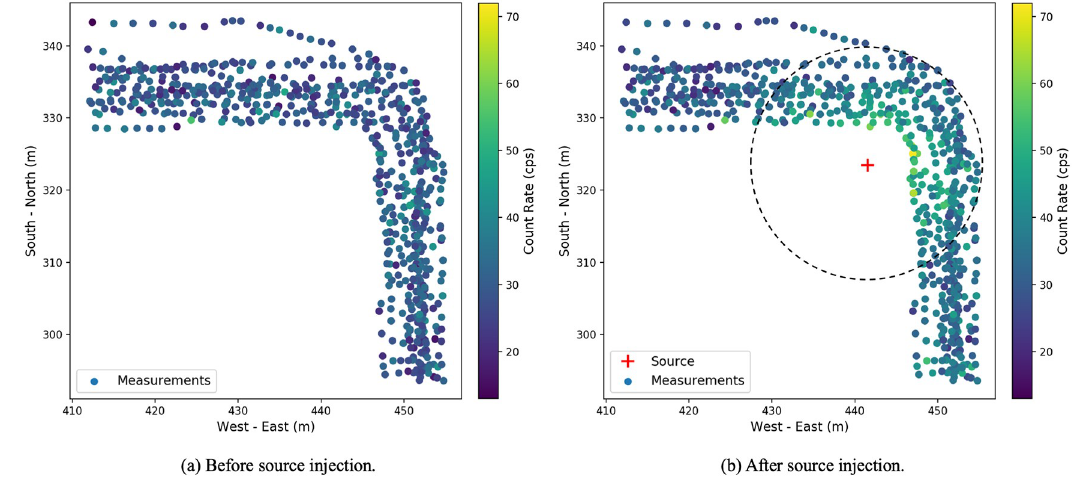
Fig 2. Illustration of synthetic source